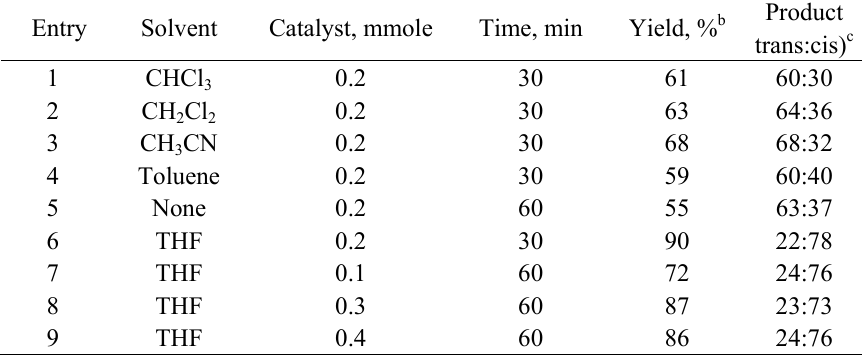
Table 1. Optimisation of catalytic and solvent condition on the reaction of aniline, benzaldehyde and 3,4-dihydro-2 H -pyran a